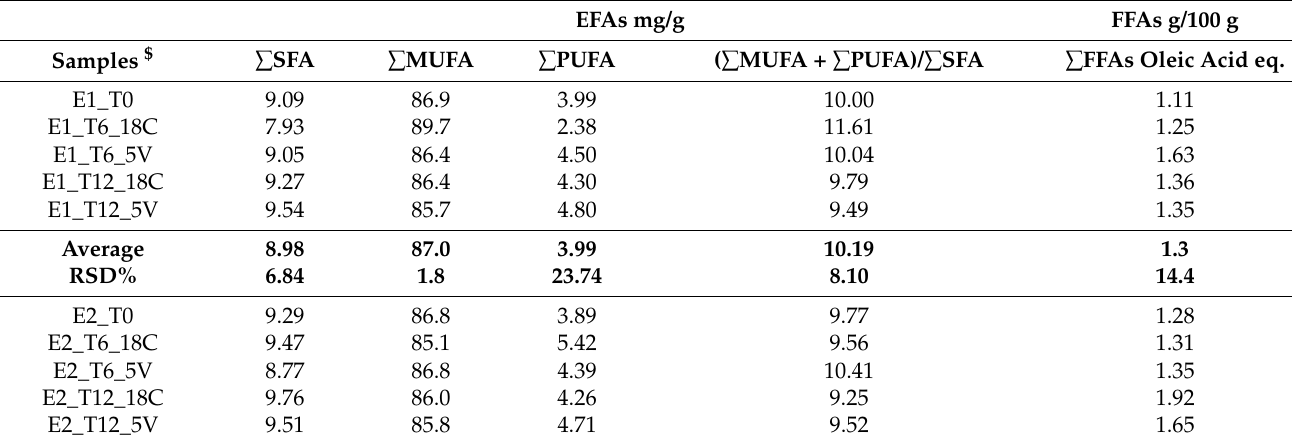
Table 4. EFA and FFA cumulative indicators of fat composition. For EFAs, values are reported in mg/g according to Supplementary Table S4 while for ∑ FFAs, the calculation refers to the sum of individual FFAs converted in oleic acid equivalents and expressed as g/100 g of